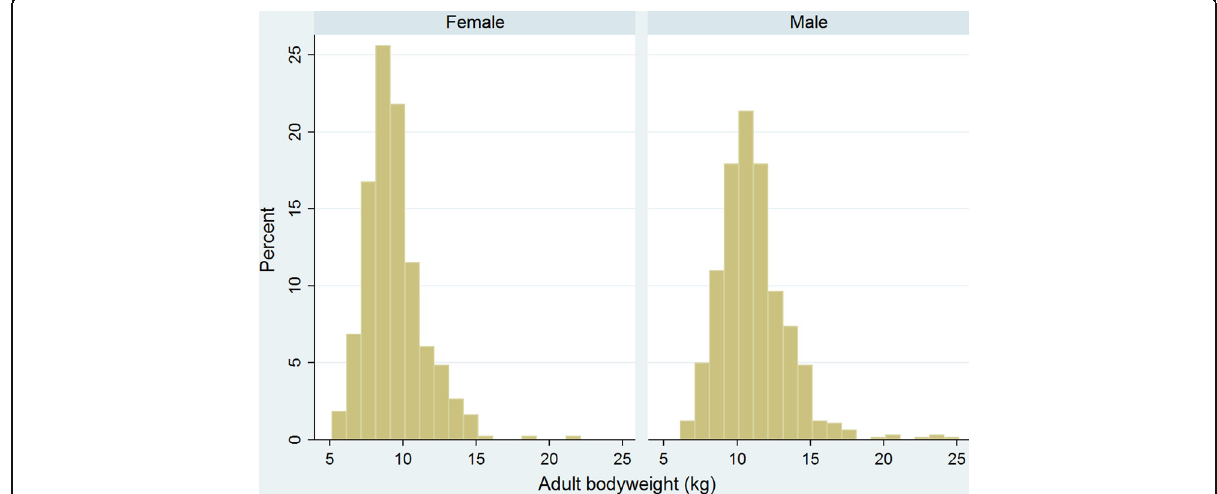
Fig. 3 Adult ( ≥ 9 months age) bodyweight distributions (kg) of 496 female and 665 male Border Terriers under veterinary care during 2013